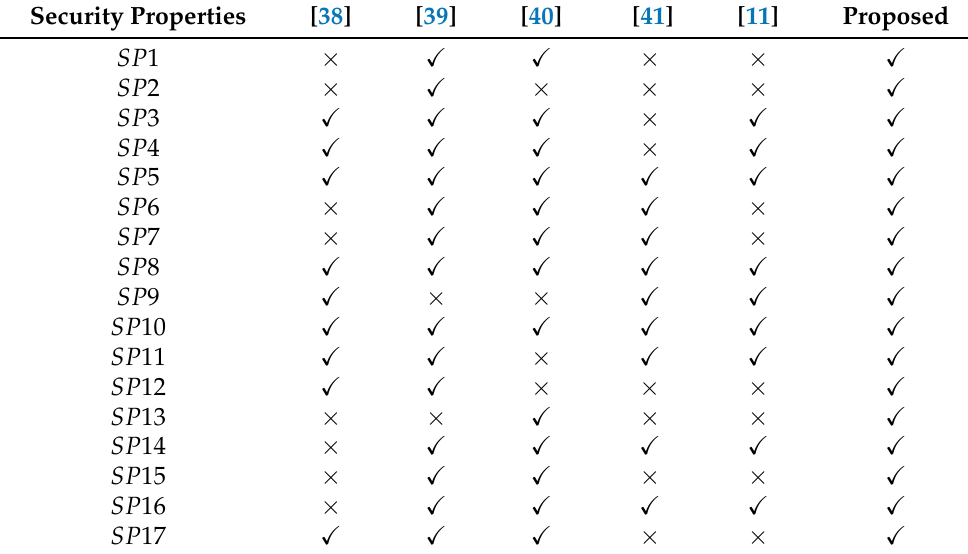
Table 4. Security and functionality features’ comparison with related schemes.